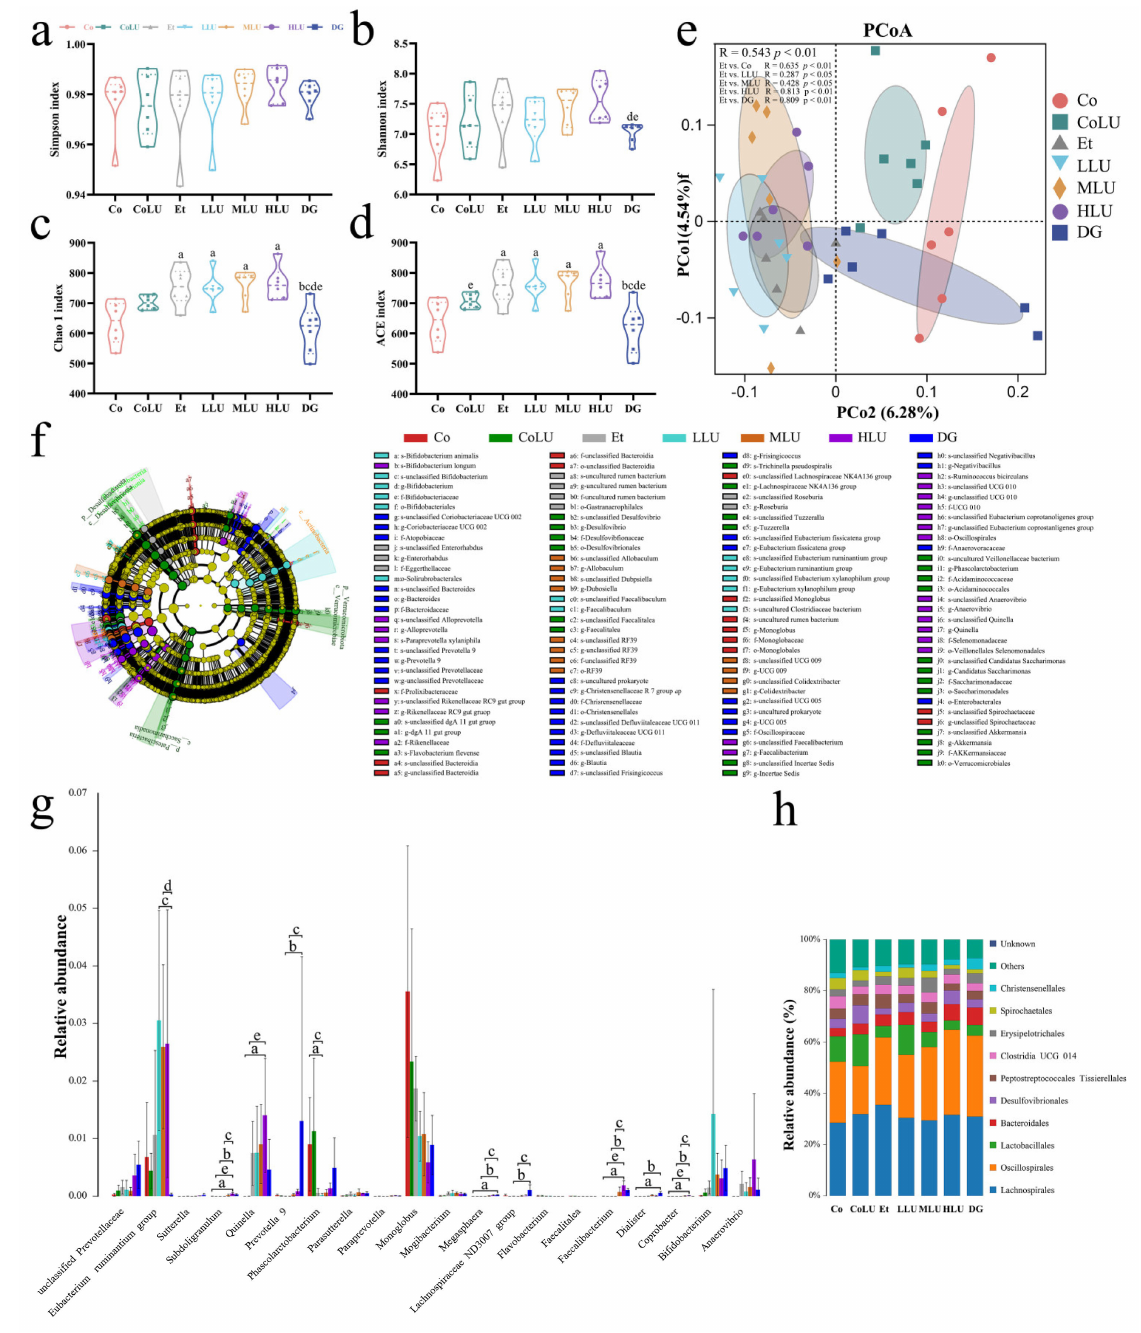
Figure 7. Effect of lutein on the microbiota of cecum contents. ( a ) Simpson index, ( b ) Shannon index, ( c ) Chao 1 index, ( d ) ACE index,; the data were expressed as M (QR). ( e ) PCoA based on unweighted unifrac distance (Analysis of Similarities (ANOSIM) analysis was used for comparison between groups: the closer the R-value is to 1, the more likely the difference among groups will be bigger than the difference within groups ( p < 0.05 indicates that the test has high confidence). ( f ) LEfSe analysis (LDA score > 2.5). ( g ) The top 20 species with the most significant differences at the genus level, followed by BH-FDR correction for results with significant differences; the data were expressed as mean ± SD. ( h ) Species distribution map at the order level ( n = 6/group). Co: normal control group; CoLU: the medium-dose lutein control group; Et: ethanol model group; LLU: the low-dose lutein intervention group; MLU: the medium-dose lutein intervention group; HLU: the high-dose lutein intervention group; DG: positive control group. a p < 0.05 vs. Co group, b p < 0.05 vs. Et group, c p < 0.05 vs. LLU group, d p < 0.05 vs. MLU group, e p < 0.05 vs. HLU